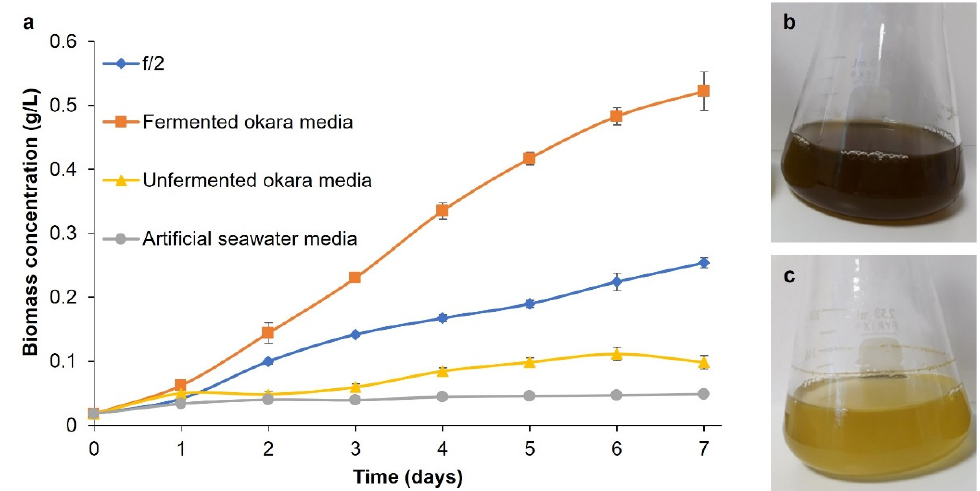
Figure 2. P. tricornutum growth in conventional media (F/2), fermented okara media, artificial seawater and unfermented okara media in terms of biomass concentration. ( a ) growth curve of P. tricornutum in different culture media; Images of algae grown in ( b ) fermented okara media; ( c ) F/2 media.